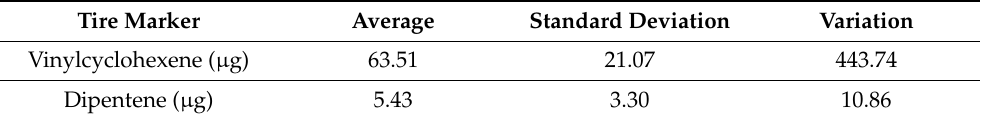
Table 1. The average mass, standard deviation, and variation for two different tire markers (vinylcy- clohexene, dipentene) measured from the tire